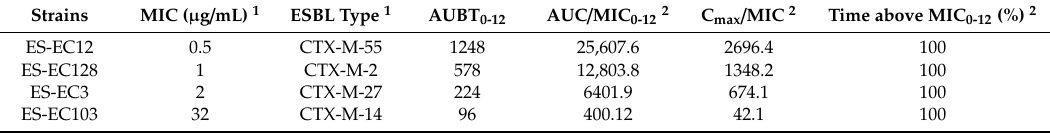
Table 1. Urinary pharmacokinetic / pharmacodynamic (PK / PD) indexes and the area under the UBT-versus-time curve within 12 h after administration (AUBT 0–12 ) of fosfomycin for the four extended-spectrum β -lactamase-producing Escherichia coli (ESBL-EC) strains tested in this study. AUC / MIC 0–12 , area under the curve / minimum inhibitory concentration during the test